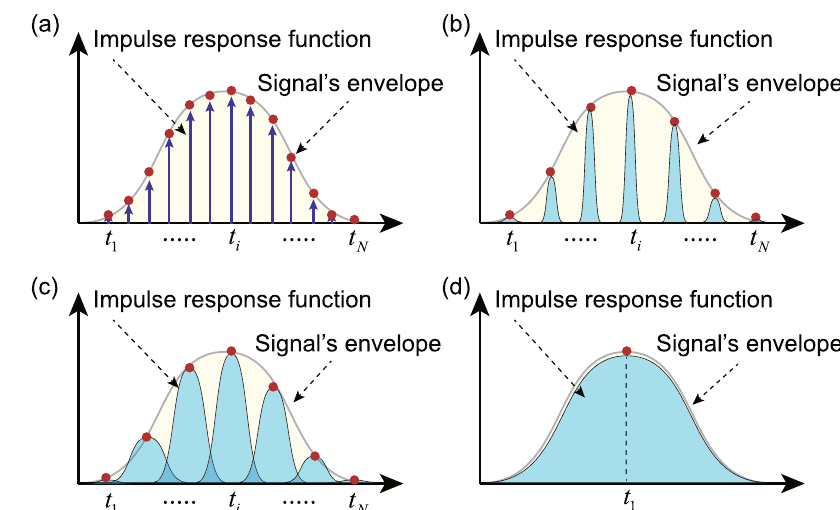
Fig. 2 Weighted averaging of sampled data. Assume the LO is a continuous-wave (CW) laser. a The bandwidth of the detector is large enough, and the impulse response function (IRF) is approximate to the δ -function. The fi nal data are recovered by weighted averaging of all of the sampled data within one period, and the weight follows the shape of the measured state ’ s envelope. b , c The bandwidth of the detector is limited, resulting in a widened IRF, which convolutes the signal around each sampling point. d If the detector ’ s IRF is similar to the measured state ’ s envelope, single-point sampling can represent the fi nal